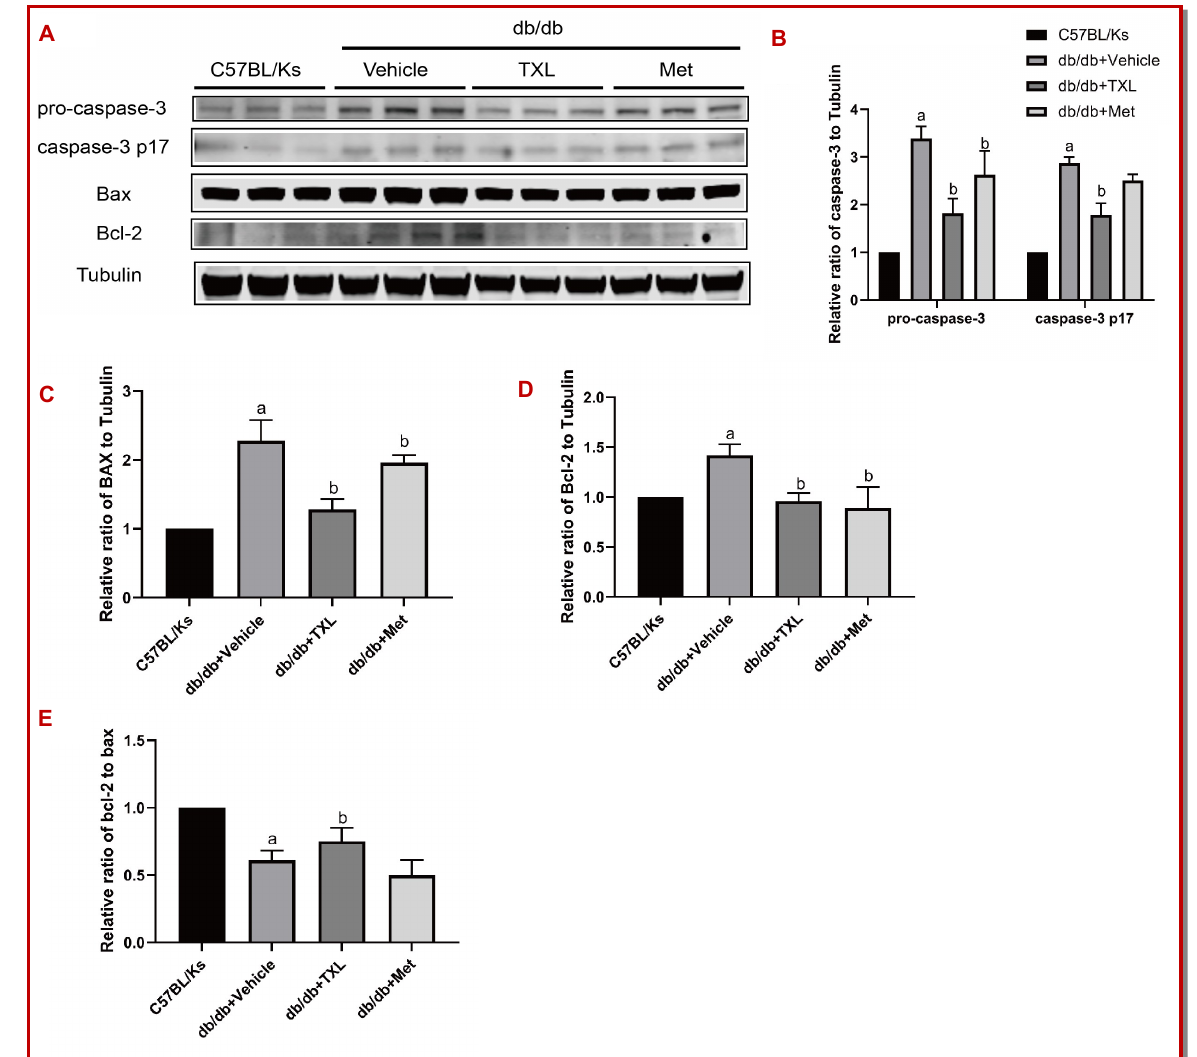
Figure 9: Effects of Tongxinluo (TXL) and metformin on apoptosis in the kidney of db/db mice. Representative band of caspase-3, Bax, Bcl-2 by Western blot in the kidneys in the different groups of mice (n=3 per group) (A); Semiquantitative analysis of average optical density of caspase-3, Bax and Bcl-2 (B~D). Relative ratio of Bcl-2 to Bax (E). a p<0.05: the significant difference with respect to C57BL/Ks control; b p<0.05: the significant difference with respect to undertreated db/db mice (model